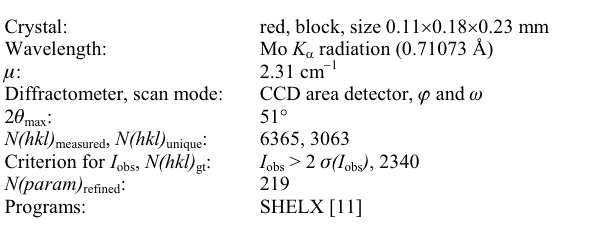
Table 1. Data collection and